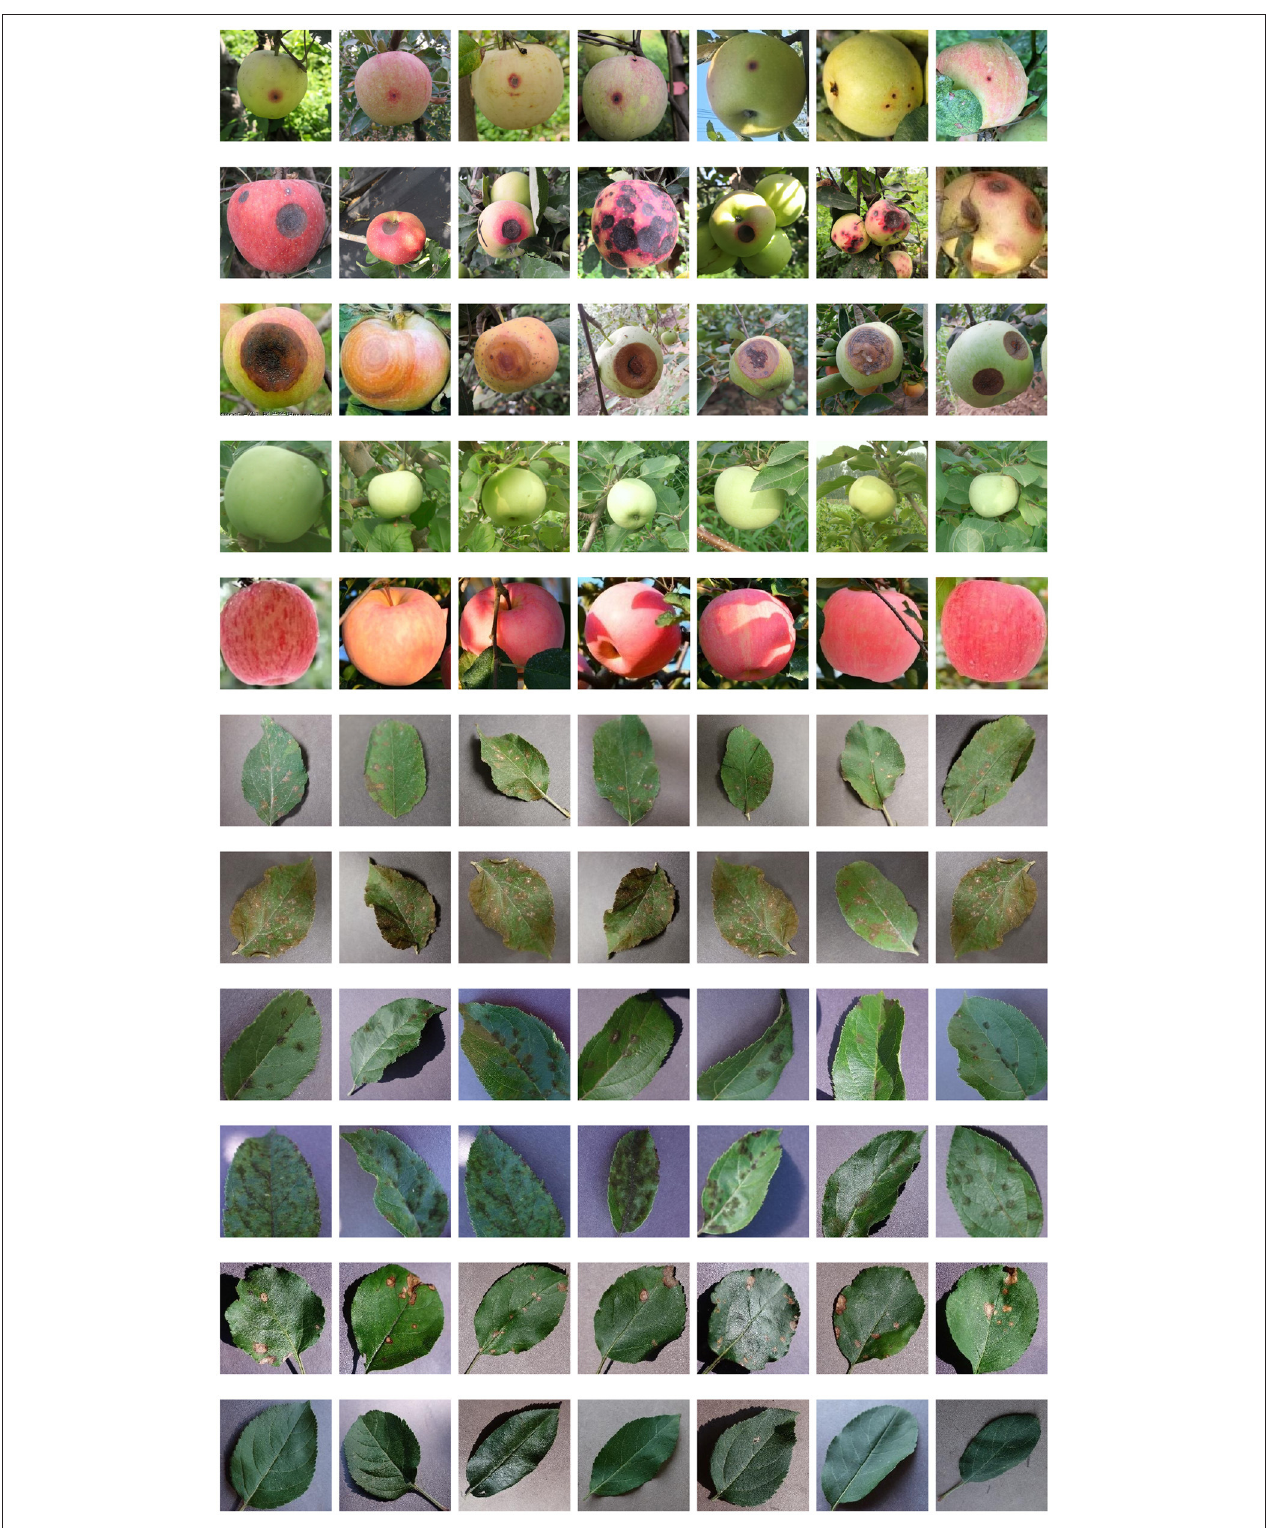
FIGURE 1 | Some images of the dataset adopted in this paper, from top to bottom , are general anthracnose, serious anthracnose, ring rot, healthy green apple, healthy red apple, general cedar apple rust, serious cedar apple rust, general apple scab, serious apple scab, apple gray spot, healthy apple leaf.